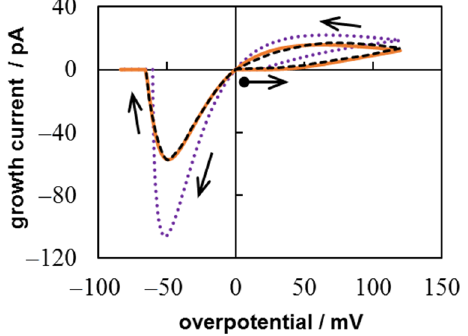
Figure 4. Comparison of simulation results for diffusion growth control at D = 1.5 × 10 − 5 с m 2 s − 1 (dotted line) and mixed growth control at D = 1.72 × 10 − 5 с m 2 s − 1 , i 0 = 6.32 × 10 − 2 A cm − 2 and α = 0.128 (solid line) with experimental CV (dashed line) [29].